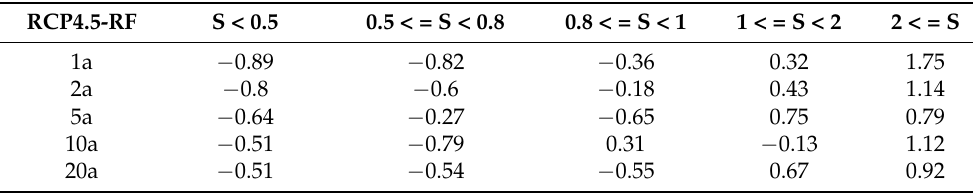
Table 11. Conduit surcharge performance RCP4.5 relative RF (unit: %).